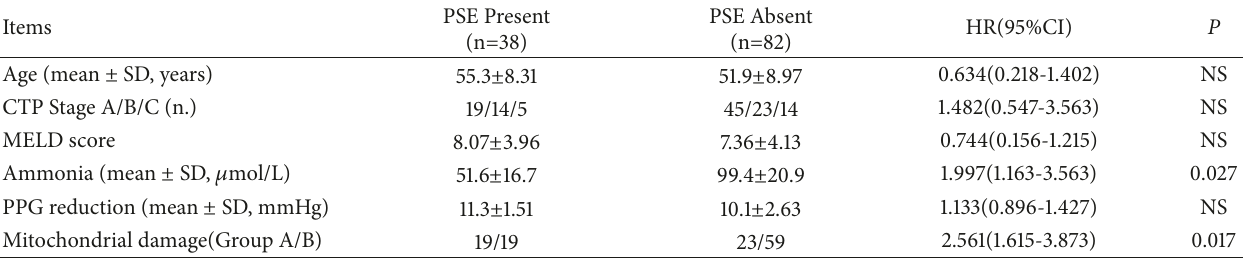
Table 3: Univariate competing risk regression for the relationship between clinical characteristics of the patients and time to PSE. Items